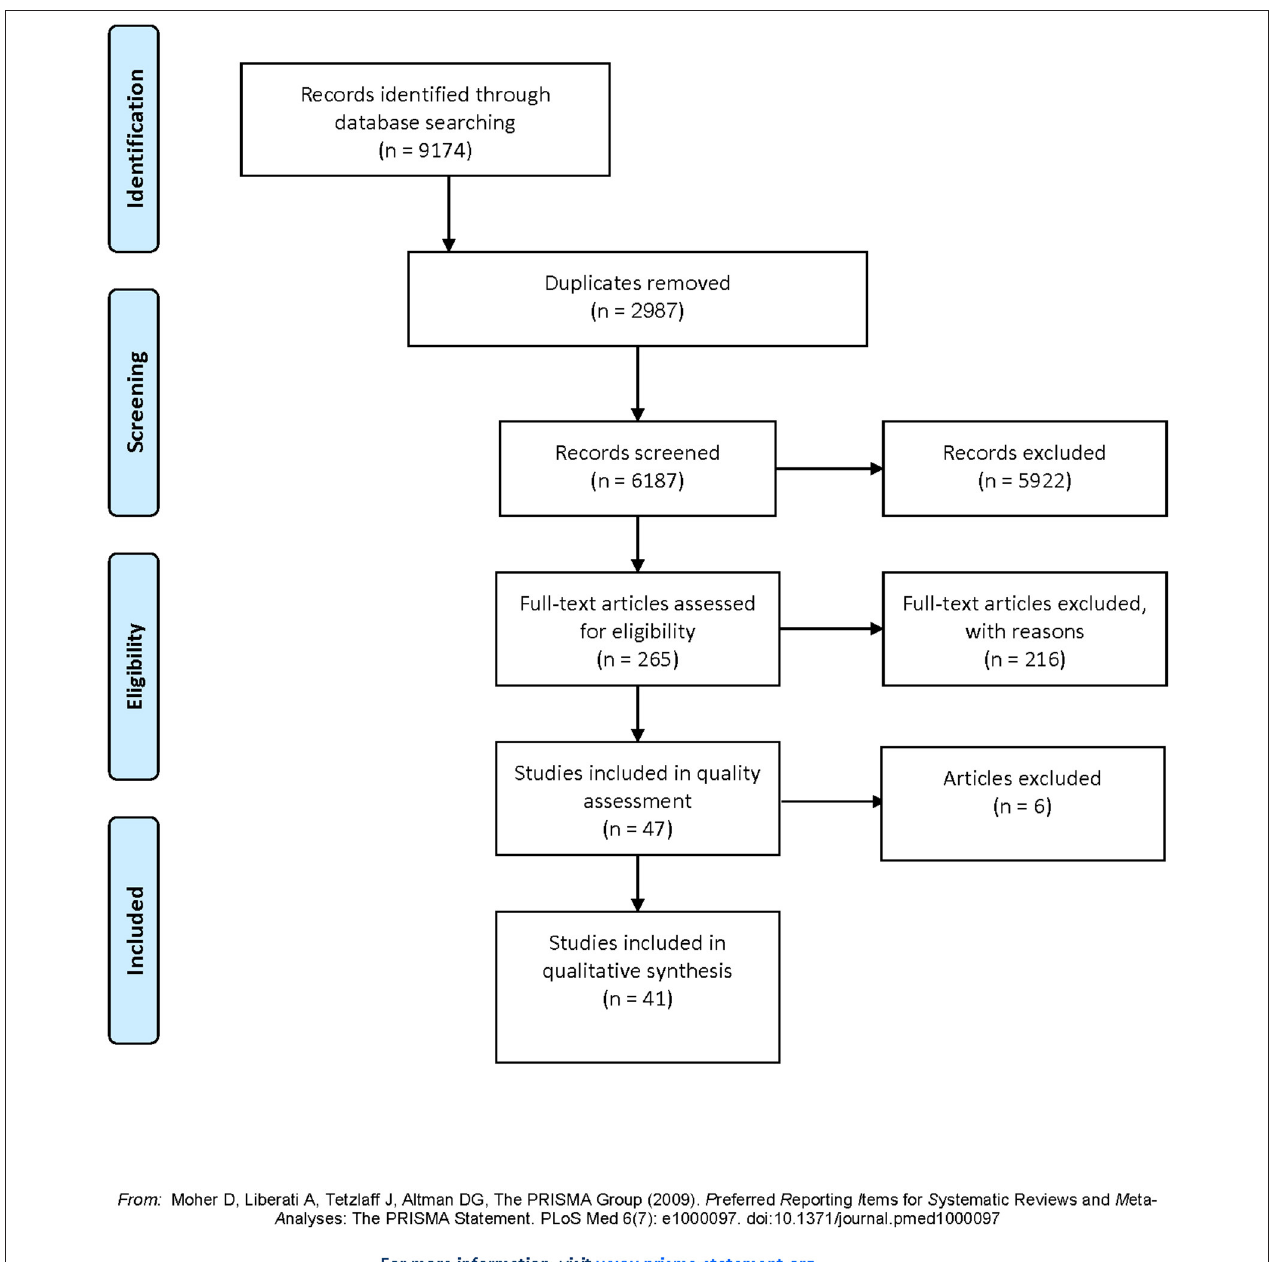
FIGURE 1 | PRISMA flow diagram of screening